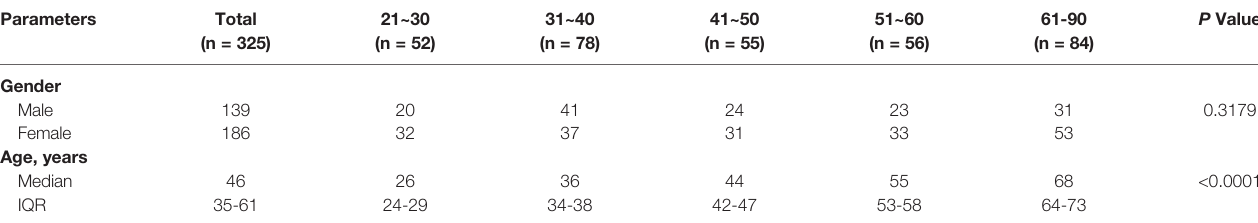
TABLE 1 | Characteristics of subjects in this study.